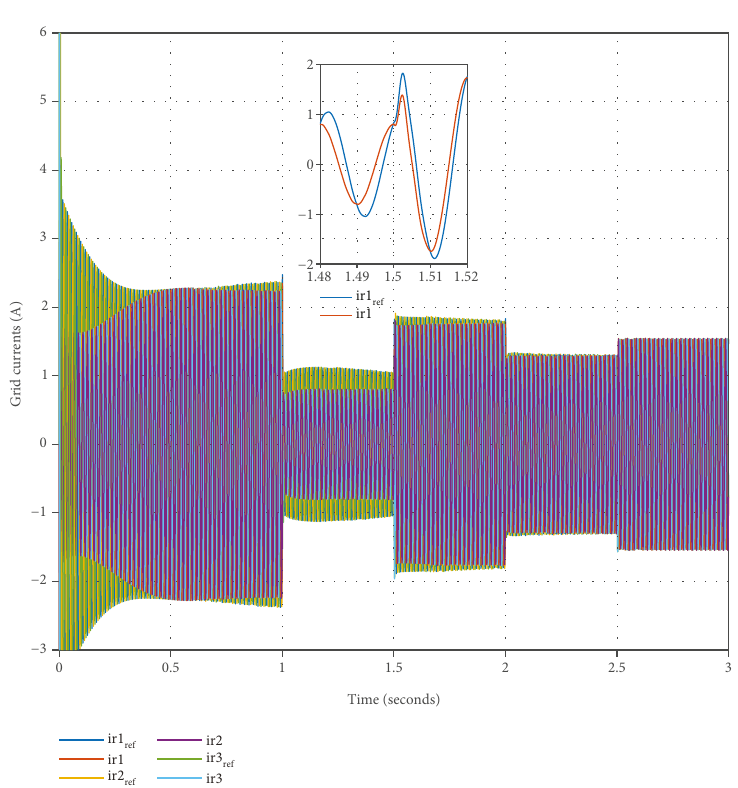
Figure 12: Grid currents (ACO-PID